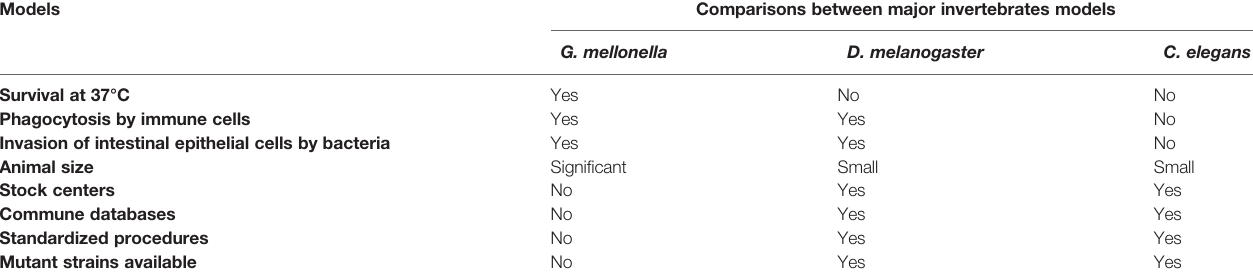
TABLE 3 | Main advantages and inconvenient among 3 major invertebrate models.